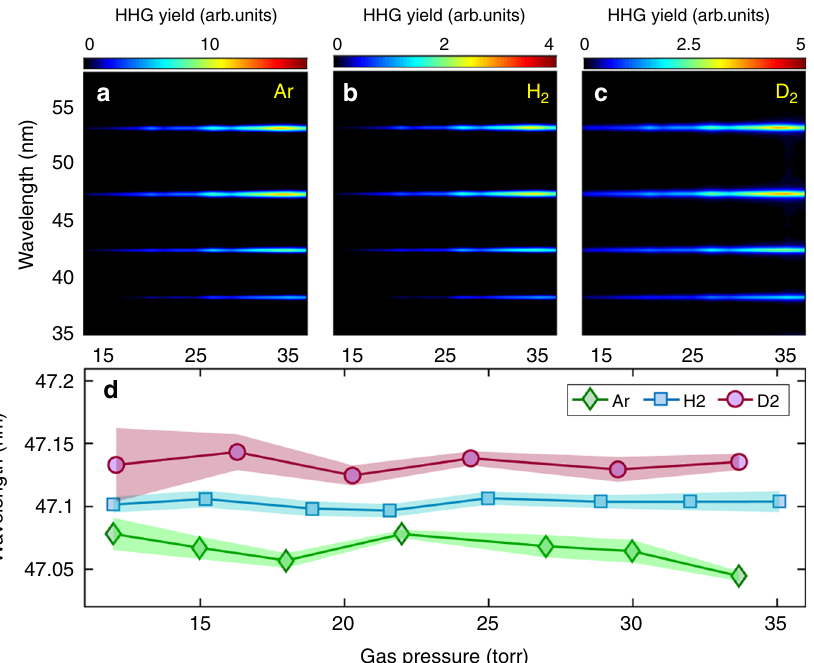
Fig. 3 Gas pressure-dependent HHG. a – c Measured harmonic spectra from Ar ( a ), H 2 ( b ), and D 2 ( c ) at different gas pressures. d The central wavelength of H17 from Ar (diamonds), H 2 (squares), and D 2 (circles) as a function of the gas pressure. Shaded areas in d represent the standard deviation of nine independent measurements